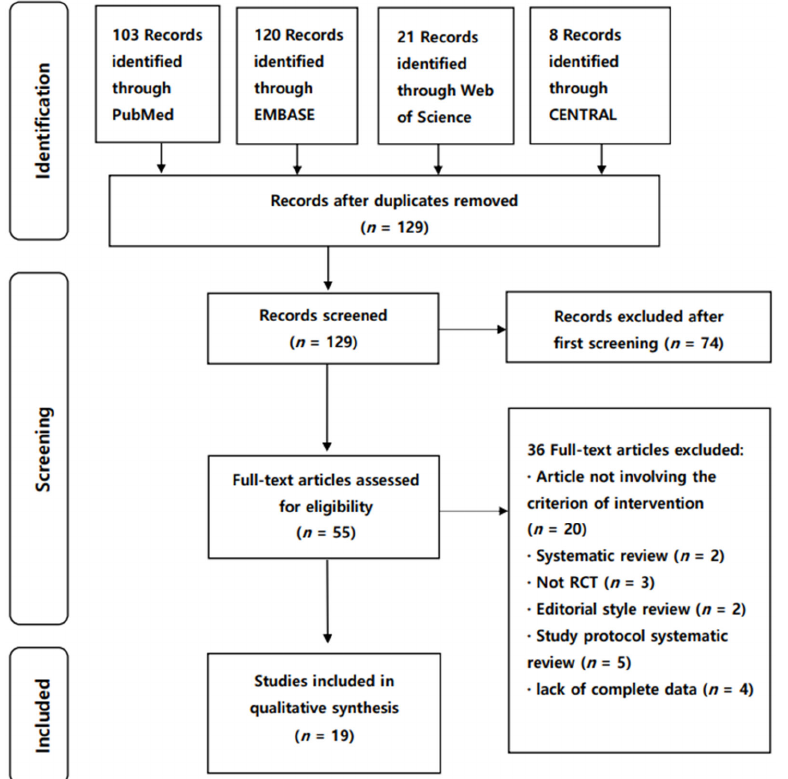
Figure 1. PRISMA flow diagram of the included NMAs. NMA, network meta ‐ analyses; RCT, randomized controlled trial.